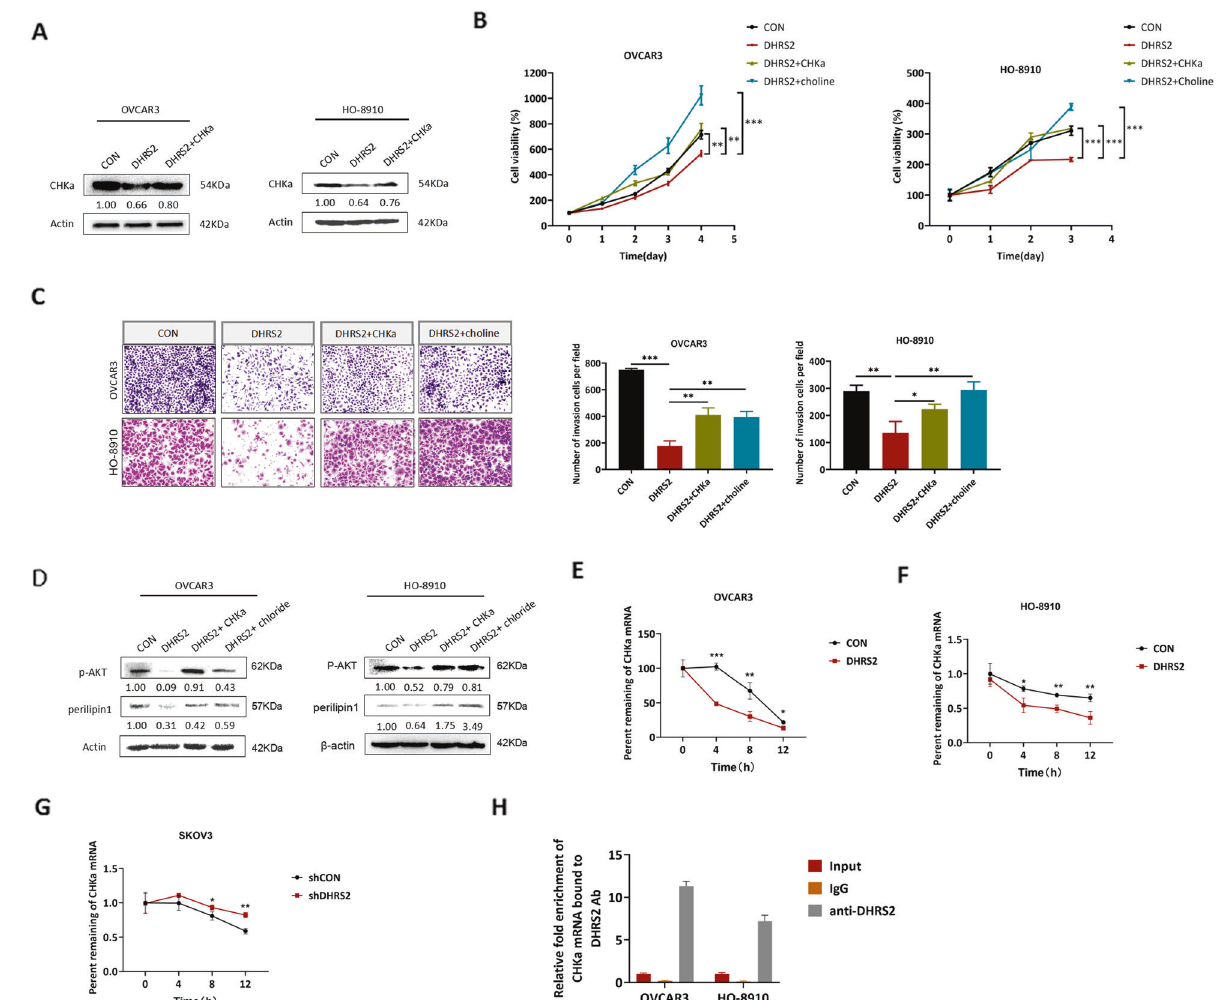
Fig. 4 Downregulation of CHK α mediates the inhibitory effect of DHRS2 on the growth and invasion of OC cells. A The protein expression levels of CHK α in the designated group. After treated with 10 μ M choline for 3 days or transfection with CHK α , B the viability of the cells was detected by MTS, C the invasive capability of the cells was determined by cell invasion assay, and D the protein levels of p-AKT and perilipin1 were detected by Western blotting. E – G After treated with actinomycin D (5 μ g/ml), CHK α mRNA levels were measured by RT-qPCR, and the percentage of remaining mRNAs in the designated group were plotted. H RIP assay showing that DHRS2 can bind to CHK α mRNA in both OVCAR3 and HO-8910 cells. Data are shown as mean values ± S.D. of independent, triplicate experiments. The asterisks (*,**,***) indicate signi fi cant differences ( p < 0.05, p < 0.01, p < 0.001,